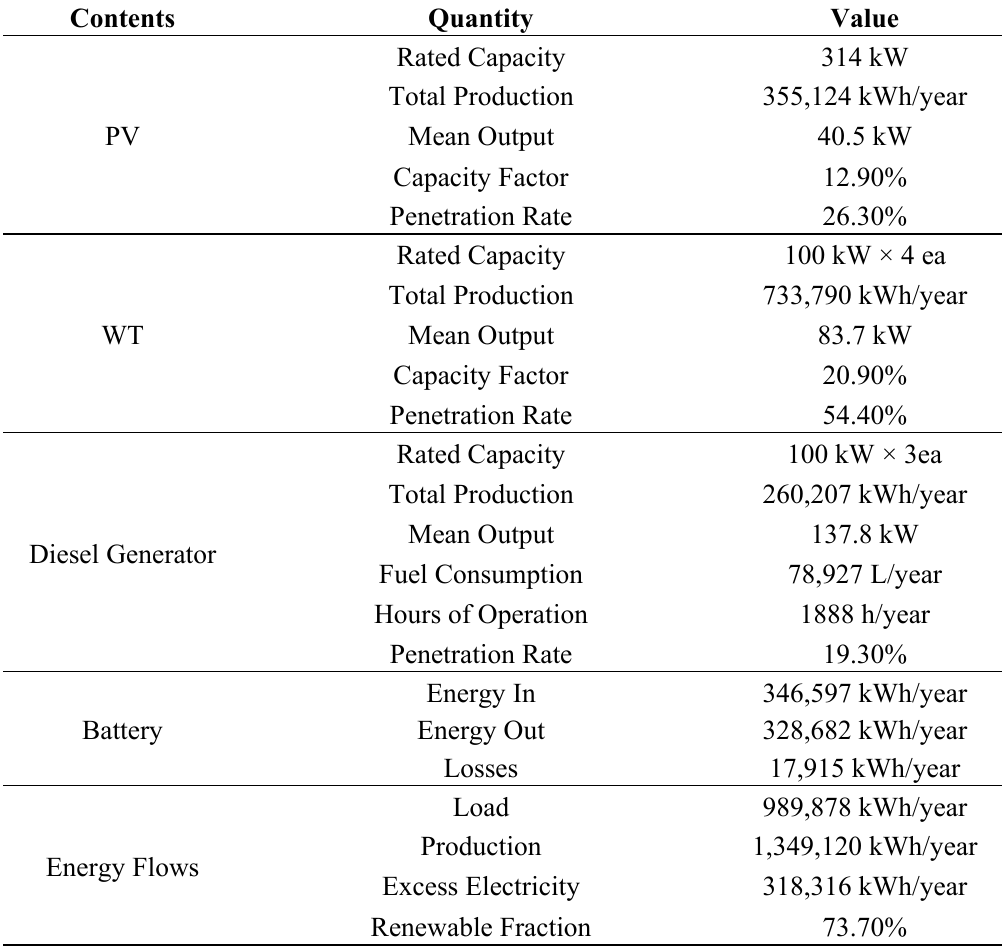
Table 5. Simulation Results for Design